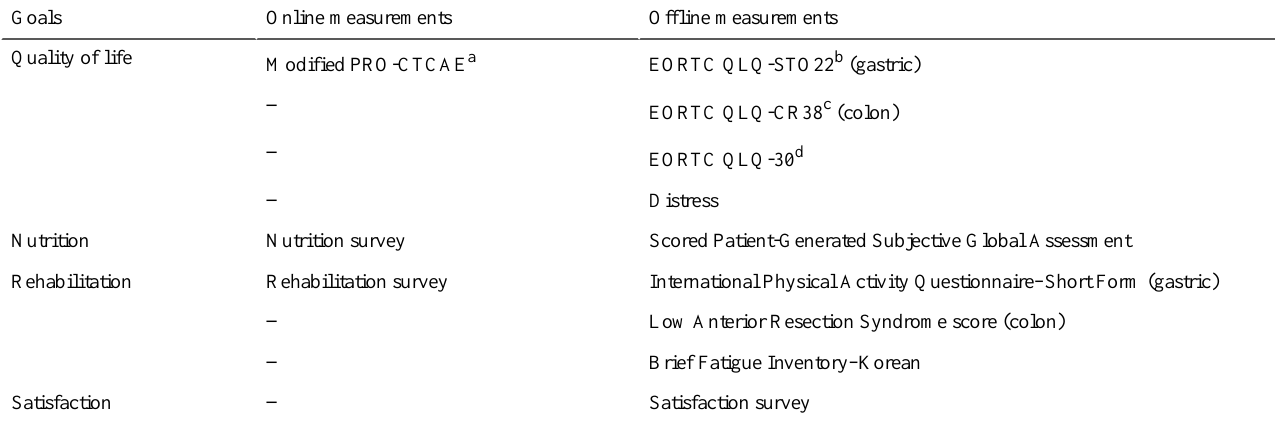
Table 1. Measurements of clinical outcome and system performance of the Life Manager.